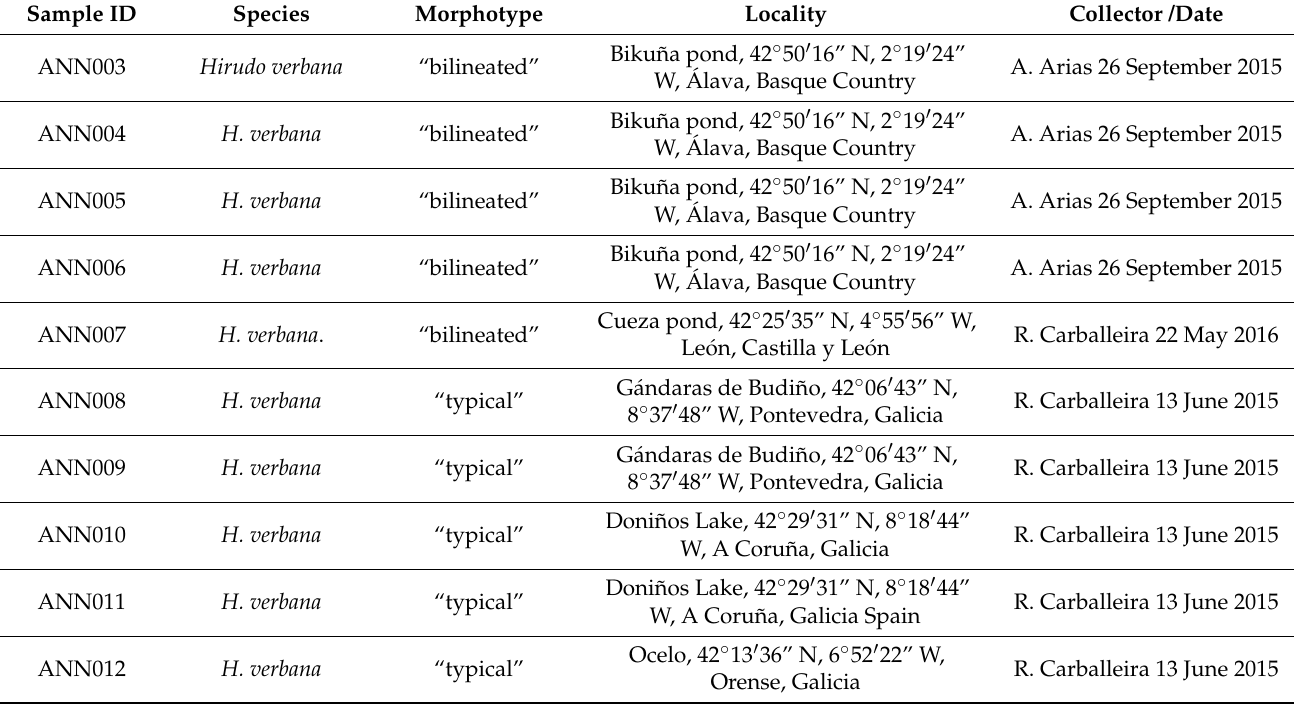
Table 1. Location of studied Spanish samples used in this analysis with combined COI and 12S mt